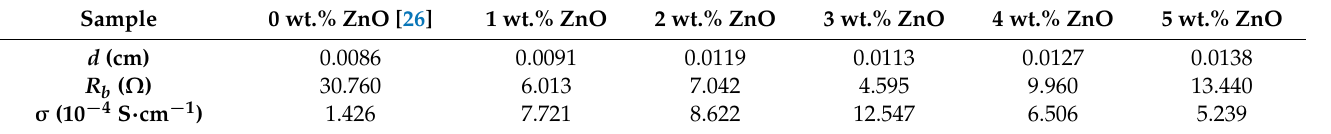
Table 3. Three parameters ( d , R b , and σ ) of the SPEs at 60 ◦